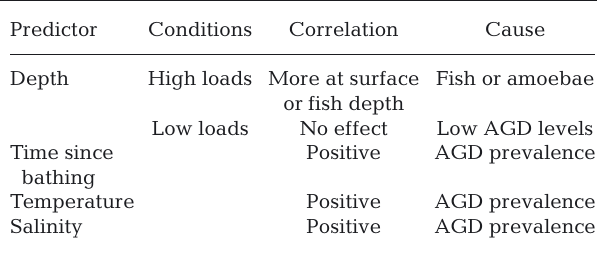
Table 2. Predictor variables selected for use in generalised lin- ear mixed models and their expected effects on Neoparamoeba perurans amoeba abundance. AGD: amoebic gill